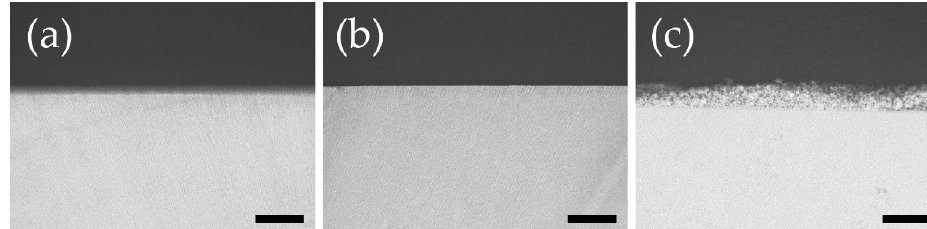
Figure 4. Optical microscopy image of contact microradiography taken at 200 magnifications after acid challenge. From the left, control group ( a ), APF group ( b ), and BioHap group ( c ). Black scale bar represented 100 μ m.